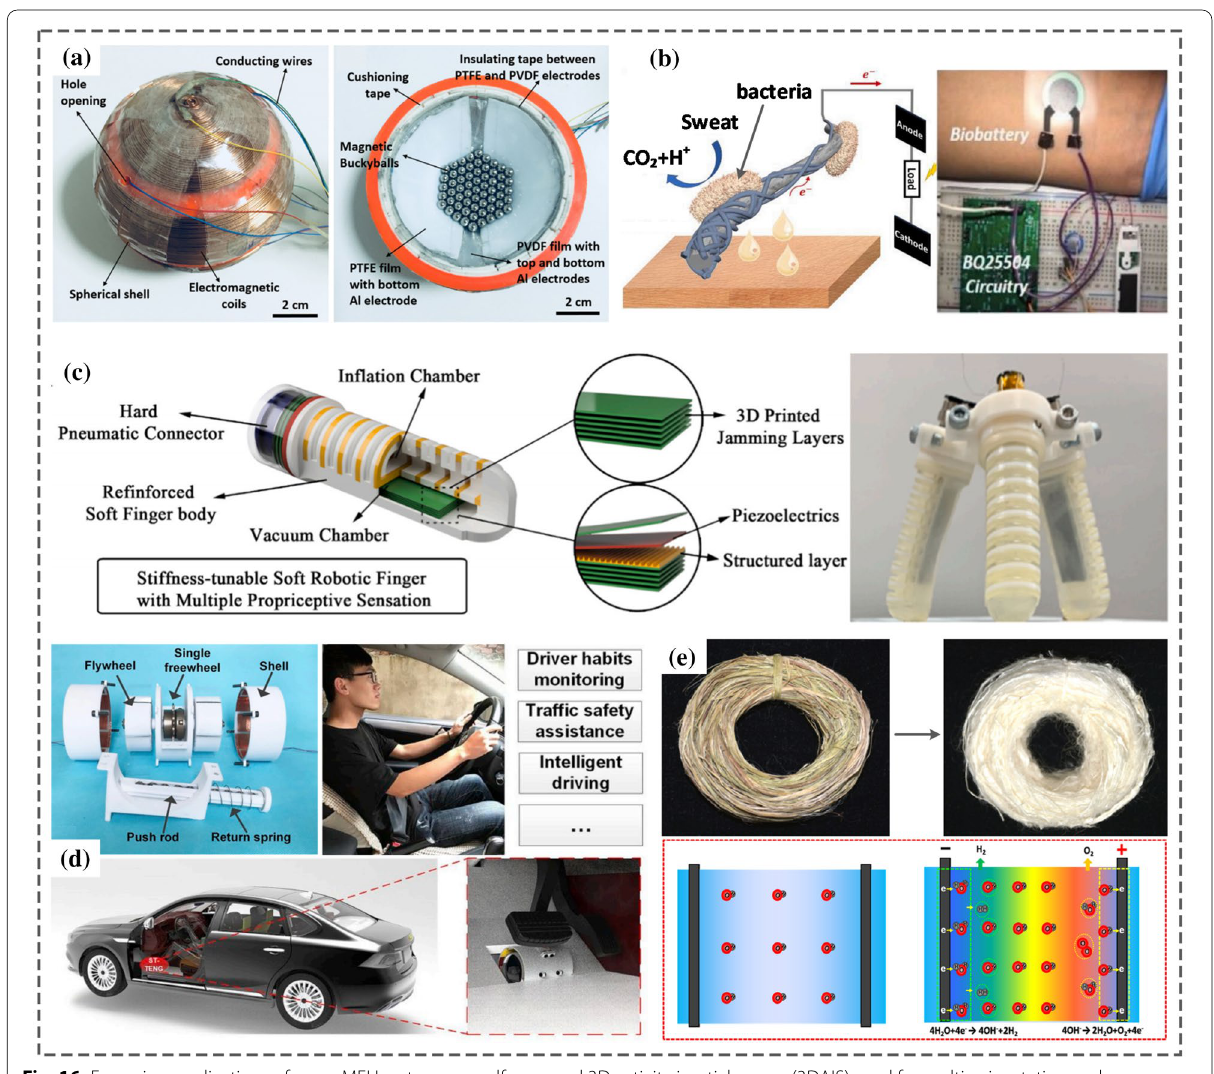
Fig. 16 Emerging applications of nano-MEH systems a a self-powered 3D activity inertial sensor (3DAIS) used for multi-axis rotation and acceleration sensing [37], b schematic of the bacterial energy harvesting from human sweat [179], c a soft robotic finger with sensing/jamming multi-functional structures and a robotic gripper for manipulation and grasping [180] d the driver monitoring TENG and installation of the EH device in a car [181] e application of TENG for the transformation of raw ramie fiber into the degummed fiber and use of electric field provided by TENG for wastewater treatment [182], (Images are re-used with the permission of the